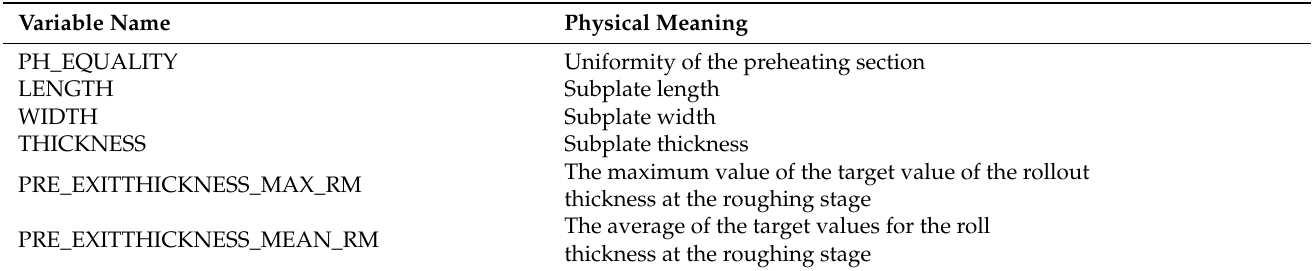
Table 1. List of properties that may affect the internal stress in the steel plate and whether it is cold straightened or